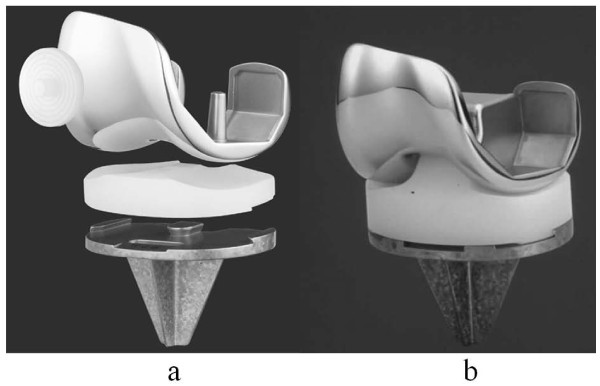
FNK CR prosthesis and FNK PS prosthesis. a: FNK CR prosthesis; b: FNK PS prosthesis.